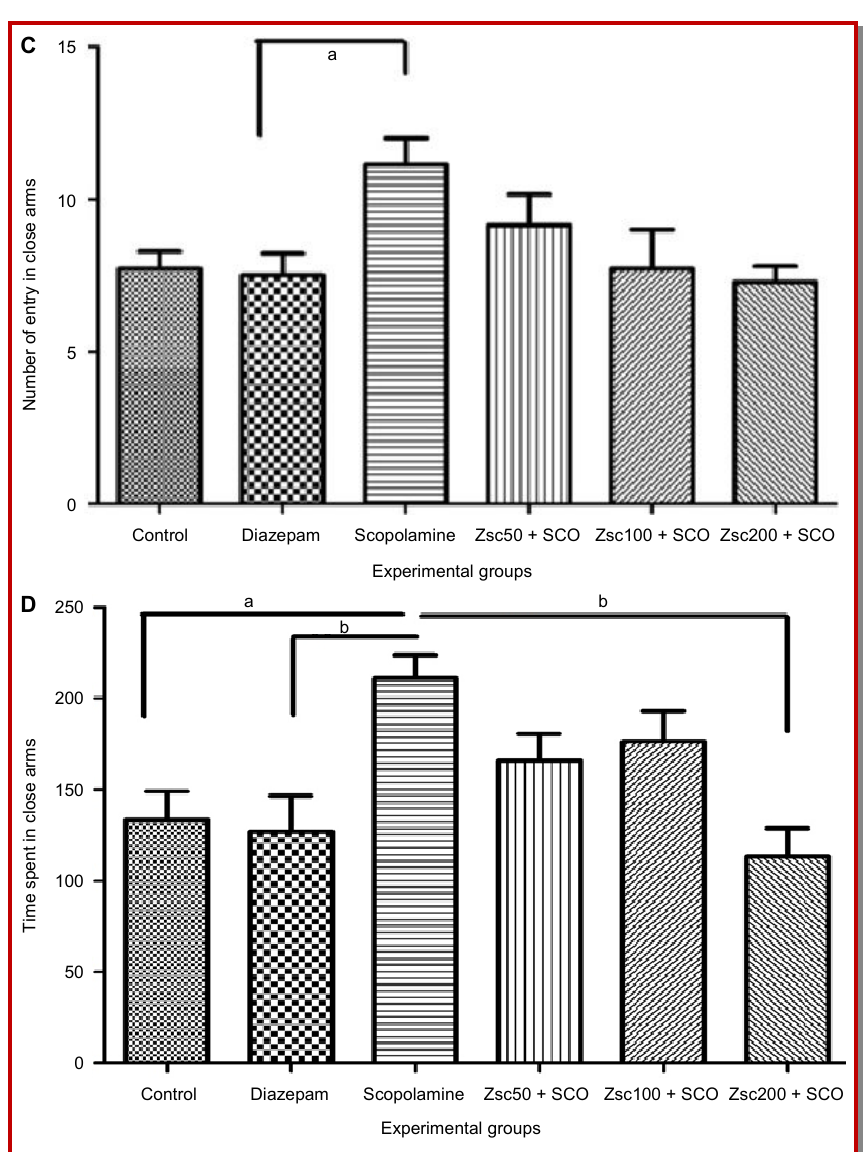
Figure 1: Effects of Z. spina-christi extract (50, 100 and 200 mg/kg) on: A) the number of entries in the open arms, B) the amount of time spent in the open arms; C) the number of entries in the closed arms; D) the amount of time spent in the closed arms. Data are presented as mean values (M ± SE)